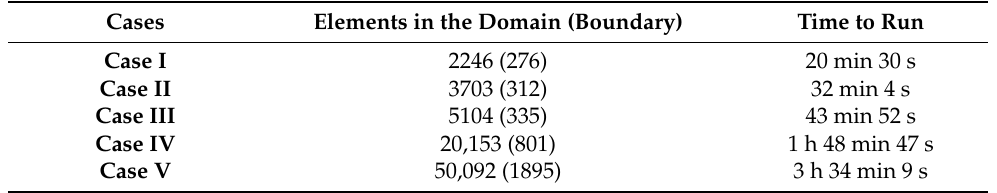
Table 2. Mesh details for cases in the mesh sensitivity study. Case III was used for subsequent